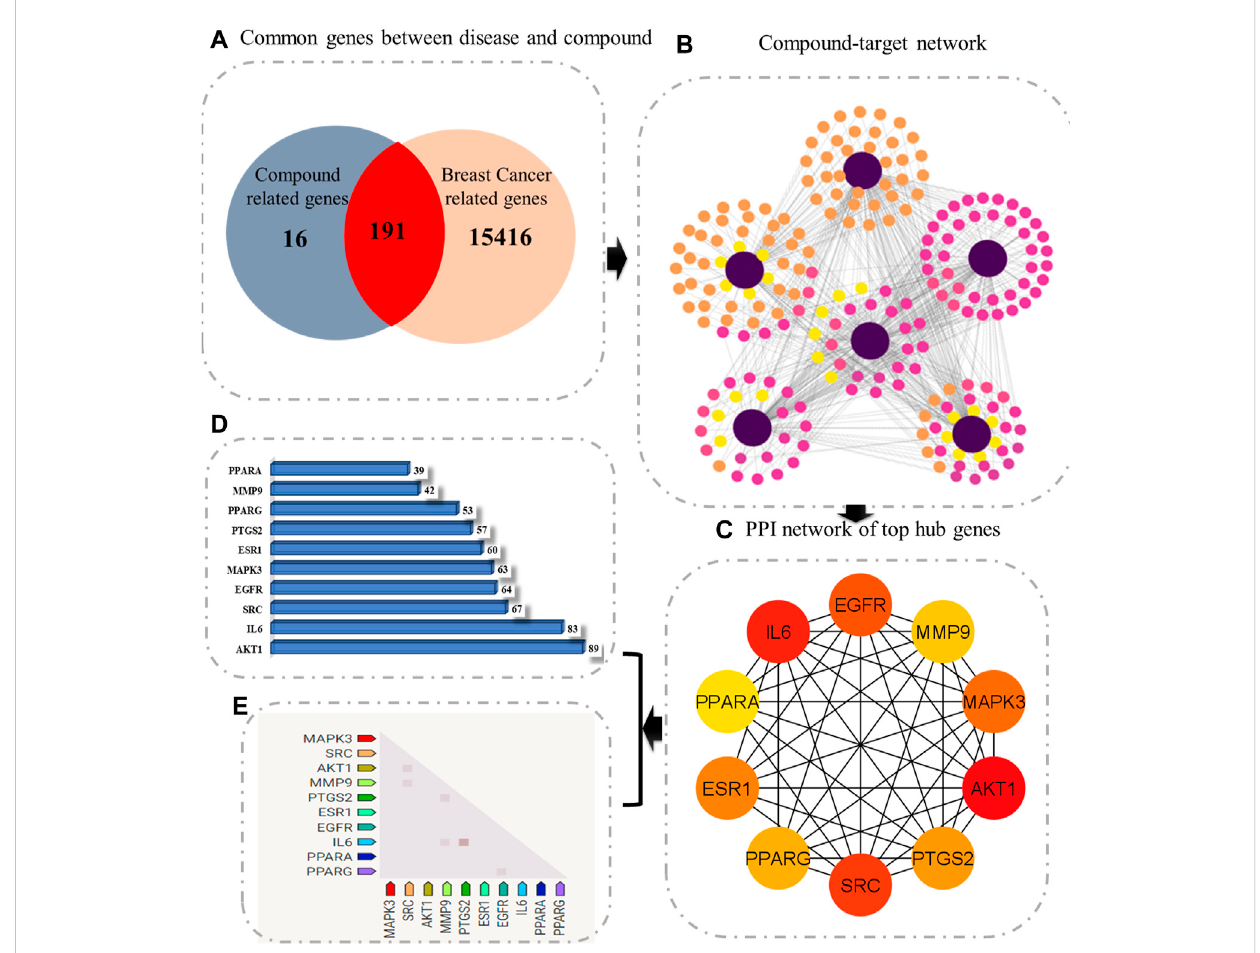
FIGURE 1 Schematic diagram representing the overall methodology for deciphering the multitarget pharmacological mechanism of C. monogyna . (A) Venn diagram representing the common genes between plant-related compounds and disease. (B) Compound – target network. The size and color of the nodes represent their degree of connectivity. The higher the degree, the greater the size of the node. (C) Ranking of key genes based on degree of connectivity. (D) Bar plot representing the degree of hub genes. (E) Observed expression hub genes in humans.